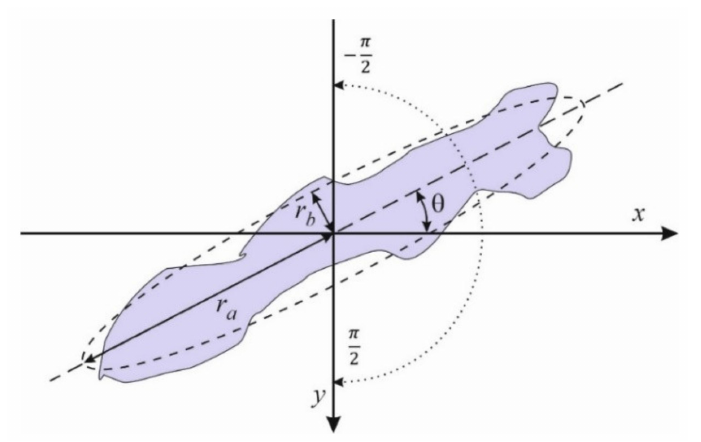
Figure 6. Defect, equivalent ellipse, and its